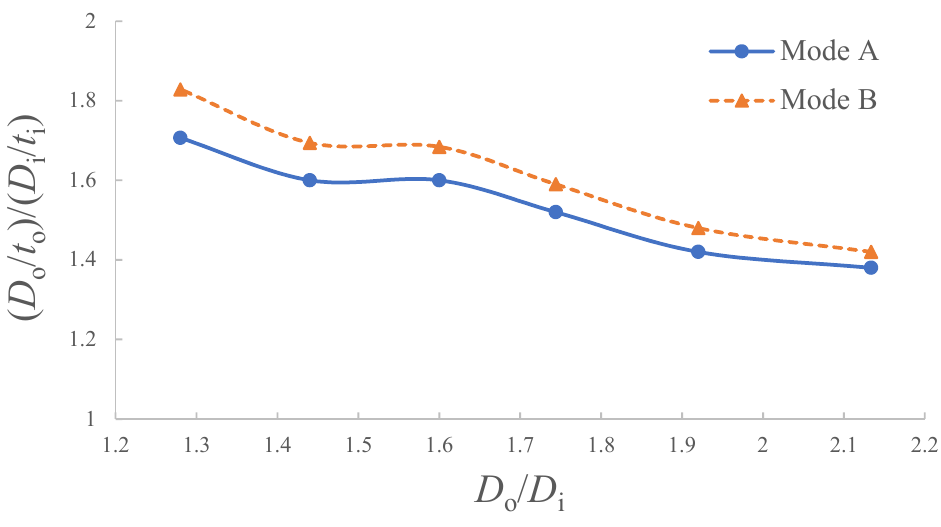
Figure 11. Critical ( D o / t o )/( D i / t i ) ratio of Mode A and B.